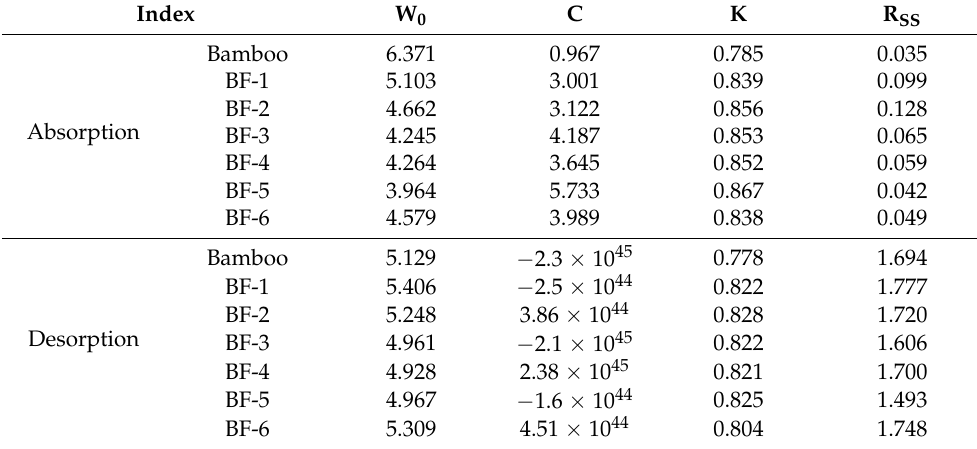
Table 3. Parameters of the GAB model for bamboo fibers with different opening times. Index